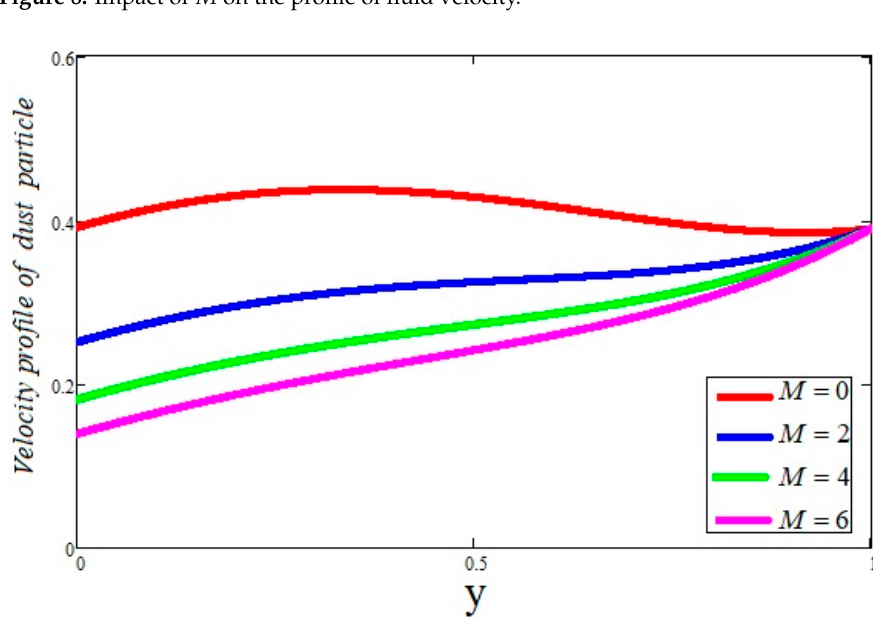
Figure 9. The impact of M on the profile velocity of dust particles.